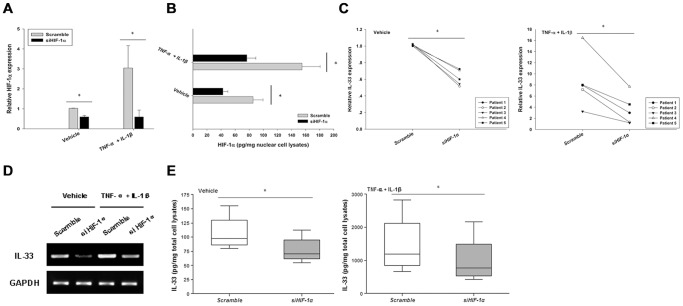
Knocking-down HIF-1α compromised IL-33 expression in RASF.A, RASF were transfected with HIF-1α siRNA or the control scramble siRNA. 24 h later, the cells were stimulated with 10 ng/ml TNF-α plus 2 ng/ml IL-1β. HIF-1α knockdown efficiency was confirmed by realtime PCR (A) and cell lysate ELISA (B) analyses. The IL-33 transcriptional levels were determined by realtime PCR (C) and RT-PCR (D) 4 h after stimulation. And also, the protein levels of IL-33 were assayed by cell lysate ELISA analysis (E) 24 h after stimulation (Wilcoxon signed-rank test, *p<0.05). The results were presented as mean±SEM of five independent experiments.